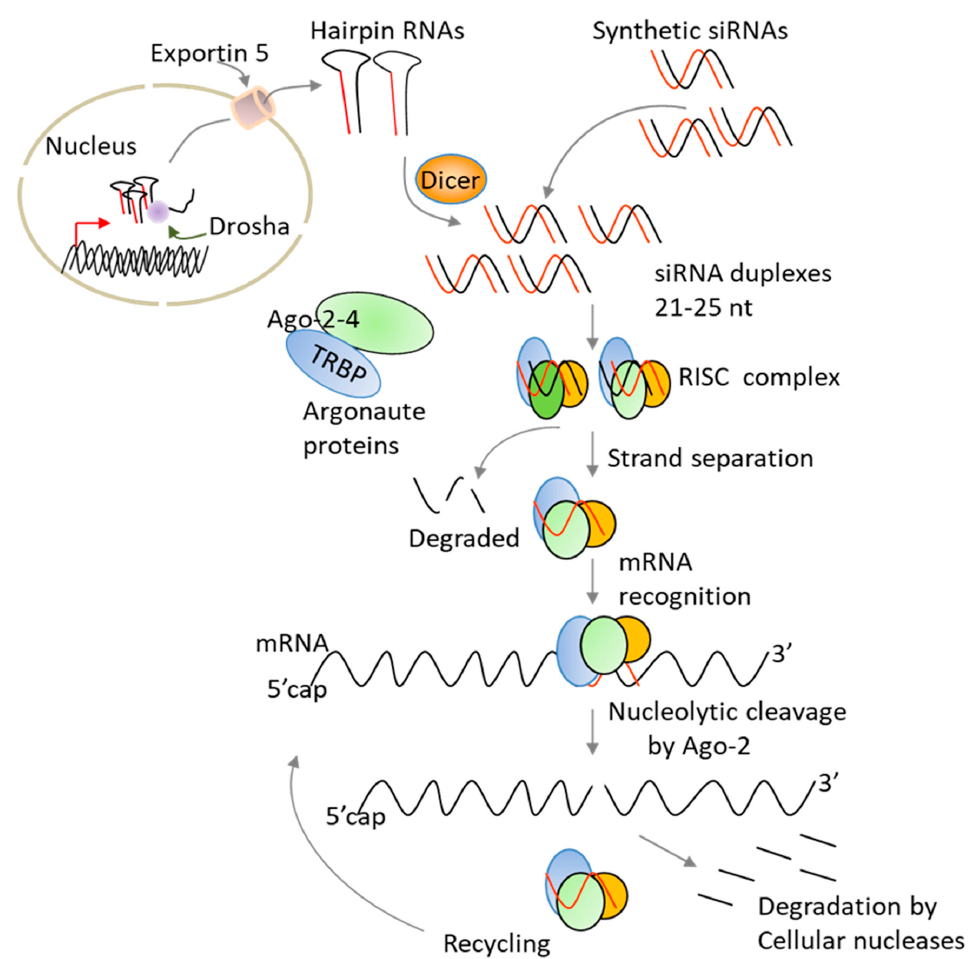
Figure 3. Schematic representation of gene silencing by siRNAs. Synthetic siRNAs are directly loaded into a multi-protein complex termed RNA-induced silencing complex (RISC) where the sense strand with high 5’-end stability is cleaved by the nuclease Argonaute 2 (Ago-2), resulting in strand separation. Subsequently, the RISC containing the antisense strand binds to complementary mRNA sequences. Gene silencing is a result of nucleolytic degradation of the targeted mRNA by Argonaute 2, a RNase H enzyme. Cleaved mRNA molecules are rapidly degraded by cellular nucleases. Following dissociation, the RISC is able to recycle and cleave additional mRNA molecules. Unlike chemically made siRNAs, hairpin RNAs (siRNAs) produced from plasmid vectors in cell nucleus are processed by Dicer in the cytoplasm before entering the RNAi pathway. Normally, hairpin RNAs and microRNAs are processed in the nucleus by the endonuclease Drosha prior to export to the cytoplasm by exportin 5. TRBP: TAR RNA-binding